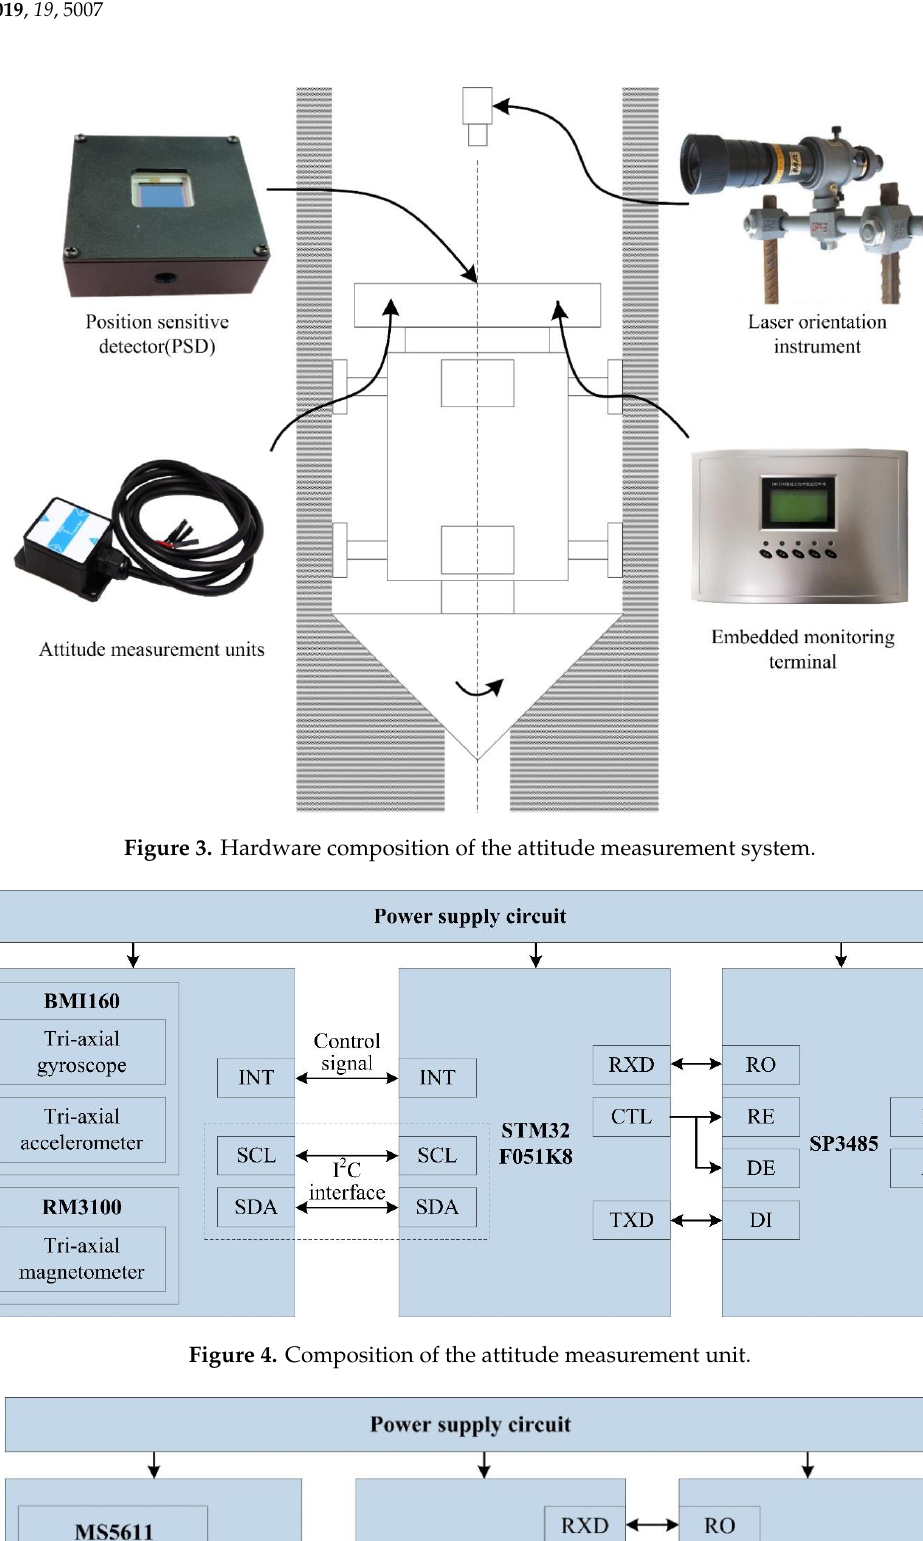
Figure 5. Composition of embedded monitoring terminal.